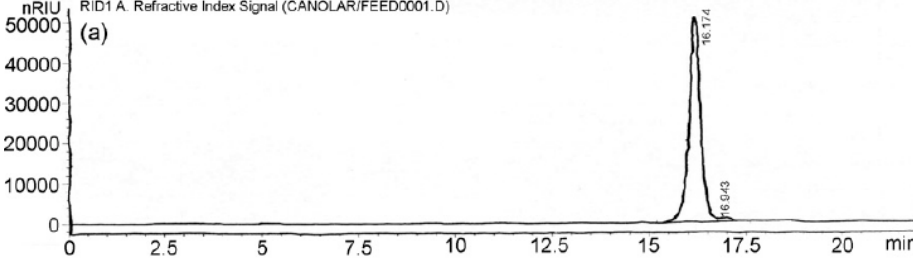
Figure 5. High-performance liquid chromatography (HPLC) chromatogram of canola oil biodiesel (reproduced with permission from [56], Elsevier, 2017). Table 1. Properties of canola oil and its blends with diesel oil [57]. BD: Canola oil biodiesel blended with diesel